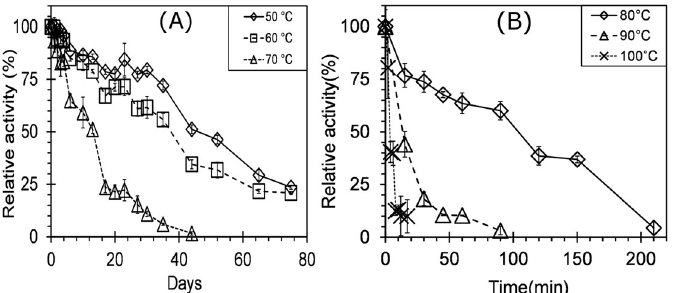
Figure 8. Thermal stability profiling of the xylanase produced by Geobacillus sp. strain DUSELR13 at different temperatures ( A ) 50–70 °C and ( B ) 80–100 °C. The enzyme activity is expressed as the percentage of the initial activity that is taken as 100%. The values are mean of triplicate experiments and the error bars represent ± SD of the means with n = 3.